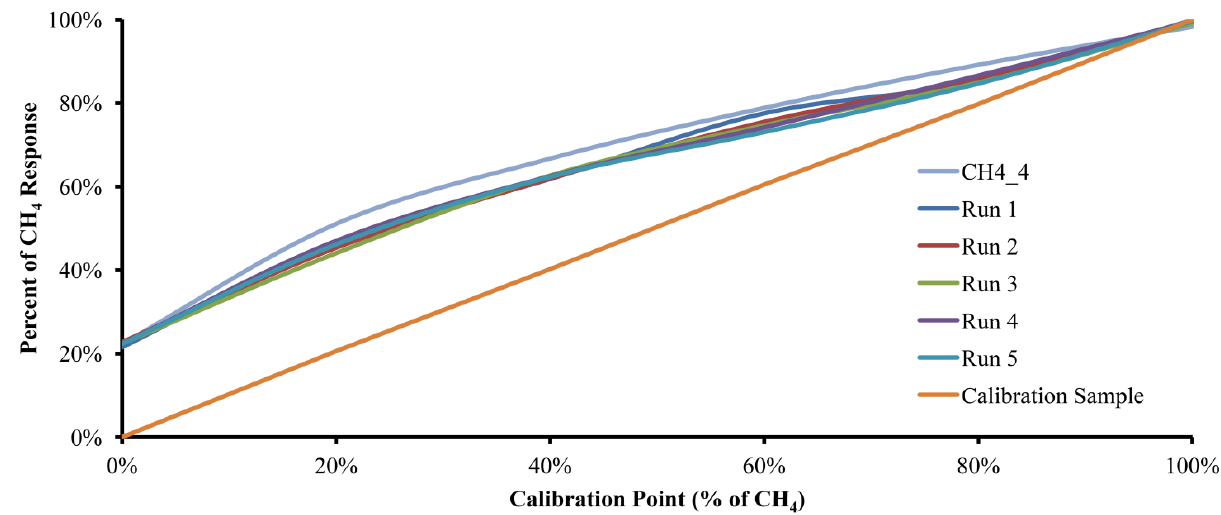
Figure 4. The experimental interday device response (run 1 to run 5). In addition, a plot of the mathematical model with 4 moles of absorption liquid and a plot of the Calibration Sample are